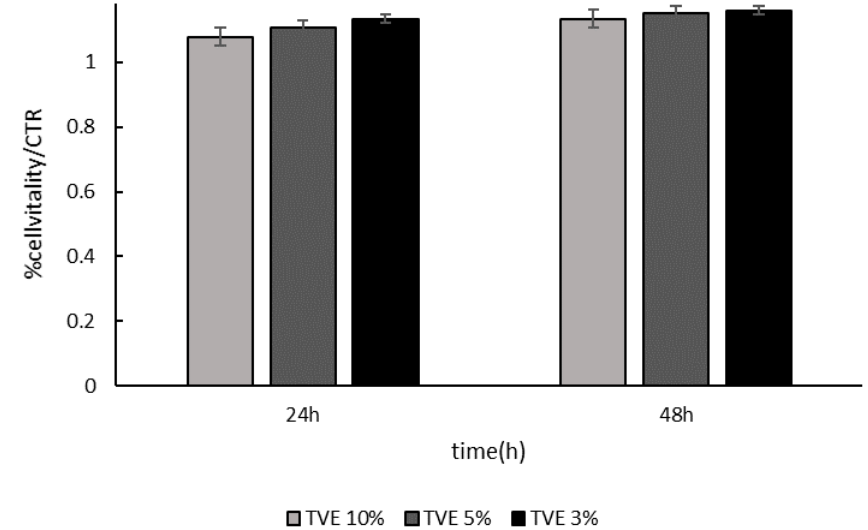
Figure 1. HaCat cell viability measurement. Cells were incubated in the presence of increasing concentrations of Triticum vulgare (TVE) (from 3% to 10%) for 24 and 48 h. Cell vitality was normalized in respect to the control.